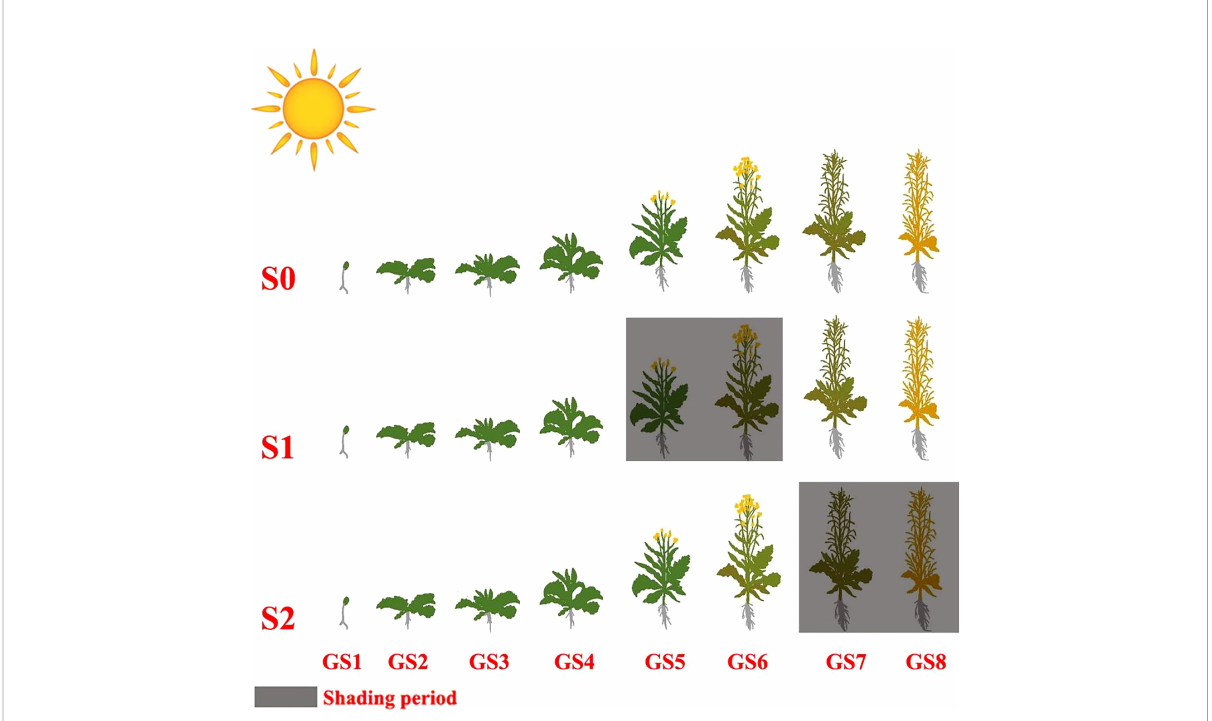
FIGURE 2 Diagrammatic representation of shading treatment at different growth stages of rapeseed. Control (ambient light) (S0); shade from GS5 to GS6 (S1); shade from GS7 to GS8 (S2); germination and emergence stage (GS1); leaf development stage (GS2); side-shoot development stage (GS3); stem prolongation stage (GS4); in fl orescence emergence (GS5); fl owering stage (GS6); pod development (GS7); harvesting stage